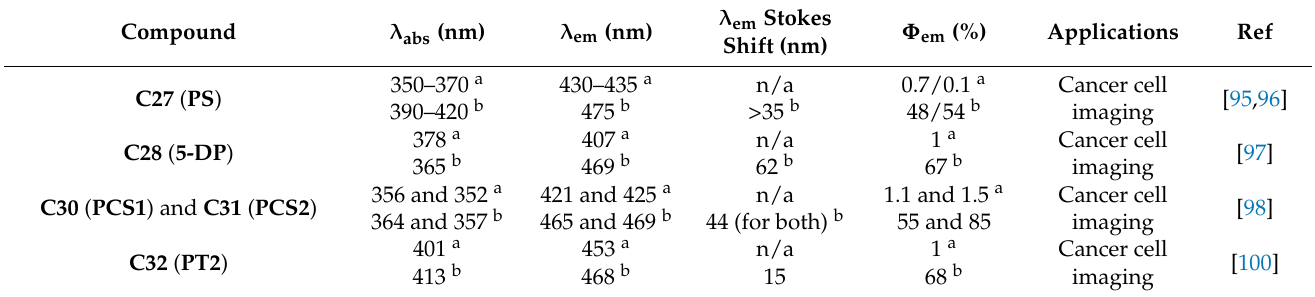
Table 3. Photophysical properties and imaging applications of important pyrene-based sensory